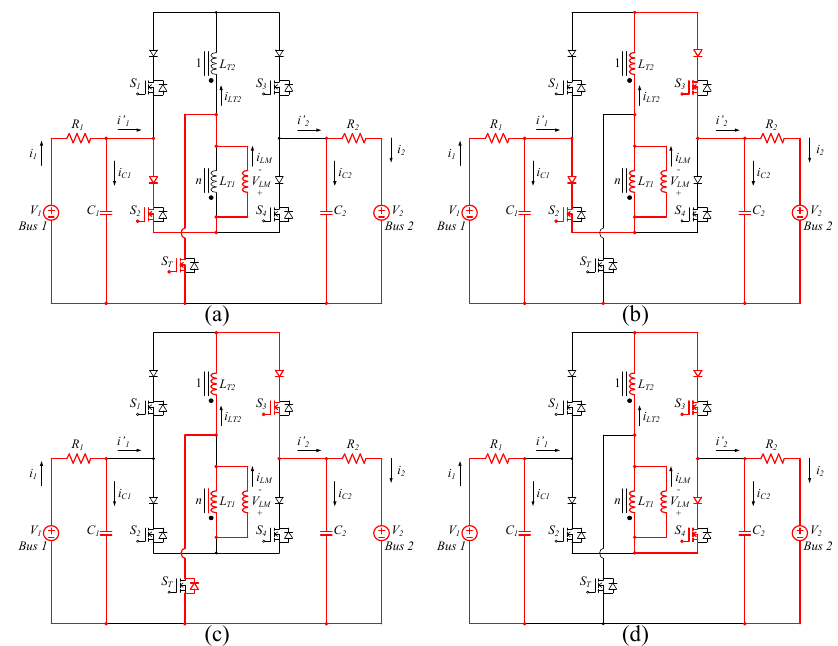
Figure 2. Current paths (in red) for the operating states of the forward mode. ( a ) State S 2 T ; ( b ) State S 23 ; ( c ) State S 3T ; ( d ) State S 34 .